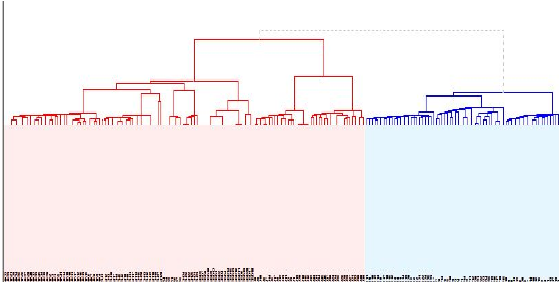
Fig. 4. Clustered result which is extracted by proposed method with k=7 of 100 Trajectories.